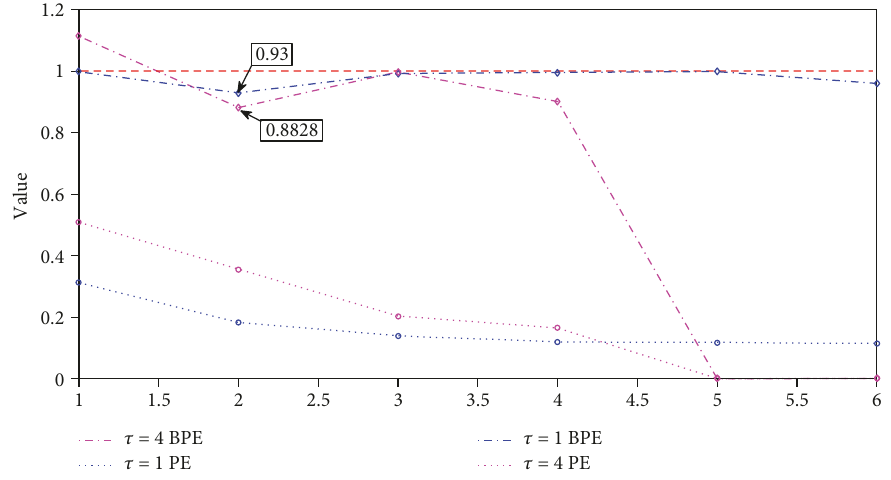
Figure 4: BPE and PE value of the IMFs in decomposition of S